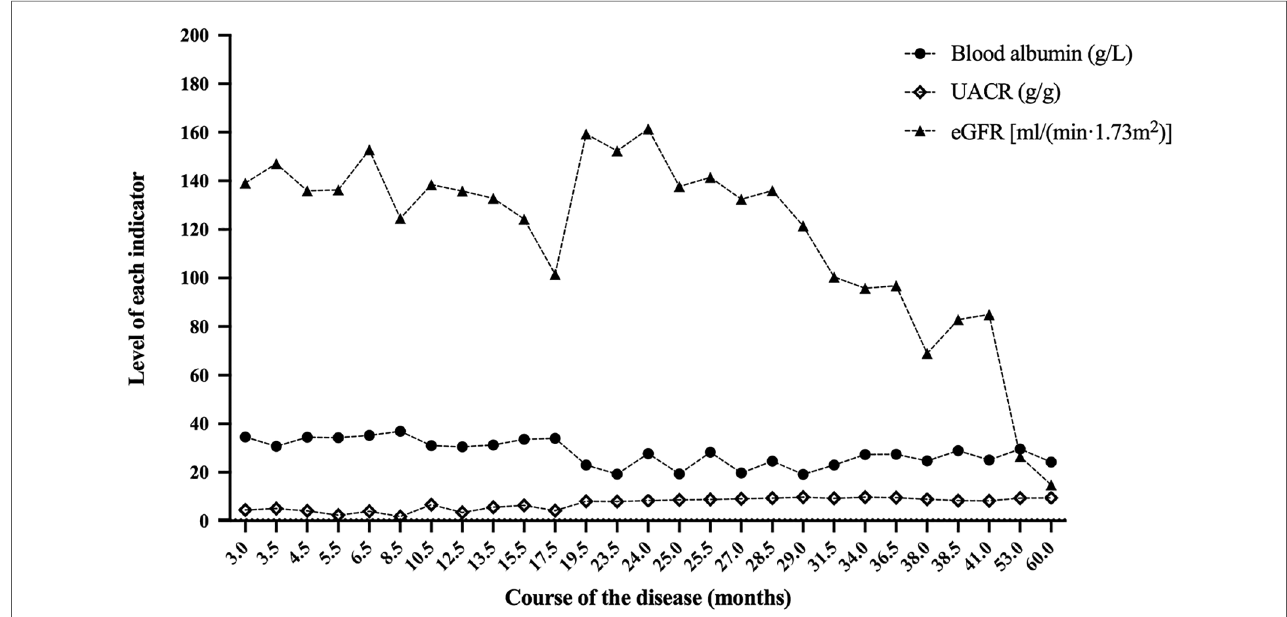
FIGURE 2 Blood albumin, UACR and eGFR at the follow-up of case 1. After 60.0 months of follow-up, the eGFR of case 1 was 14.8 ml/(min×1.73 m 2 ). UACR, urinary albumin to creatinine ratio; eGFR, estimated glomerular fi ltration rate.